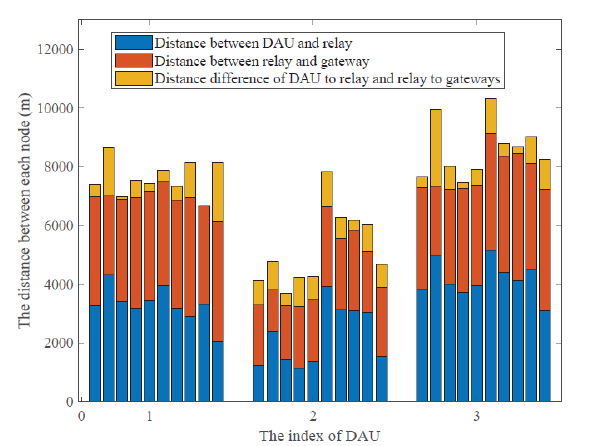
Figure 5. Distance between nodes.